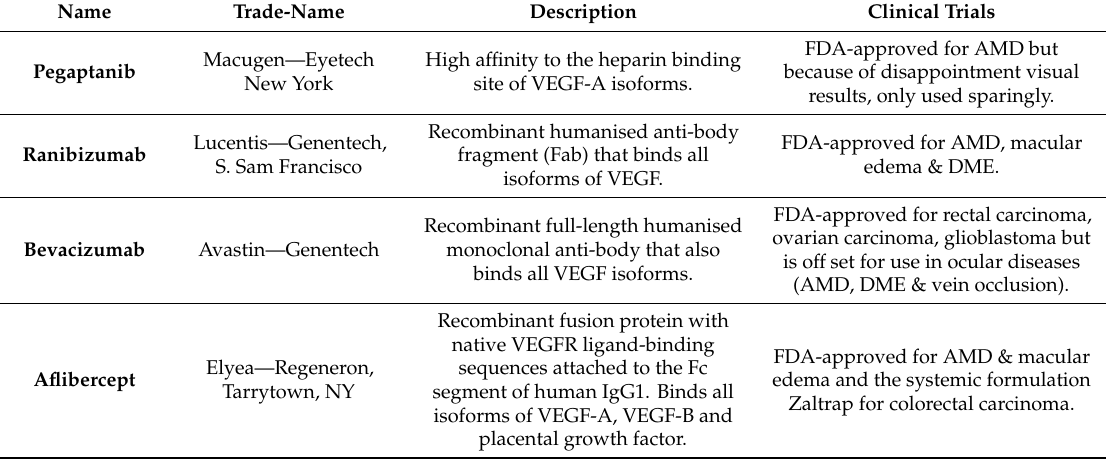
Table 1. Summary of four di ff erent anti-vascular endothelial growth factor (VEGF) drugs used in the treatment of diabetic